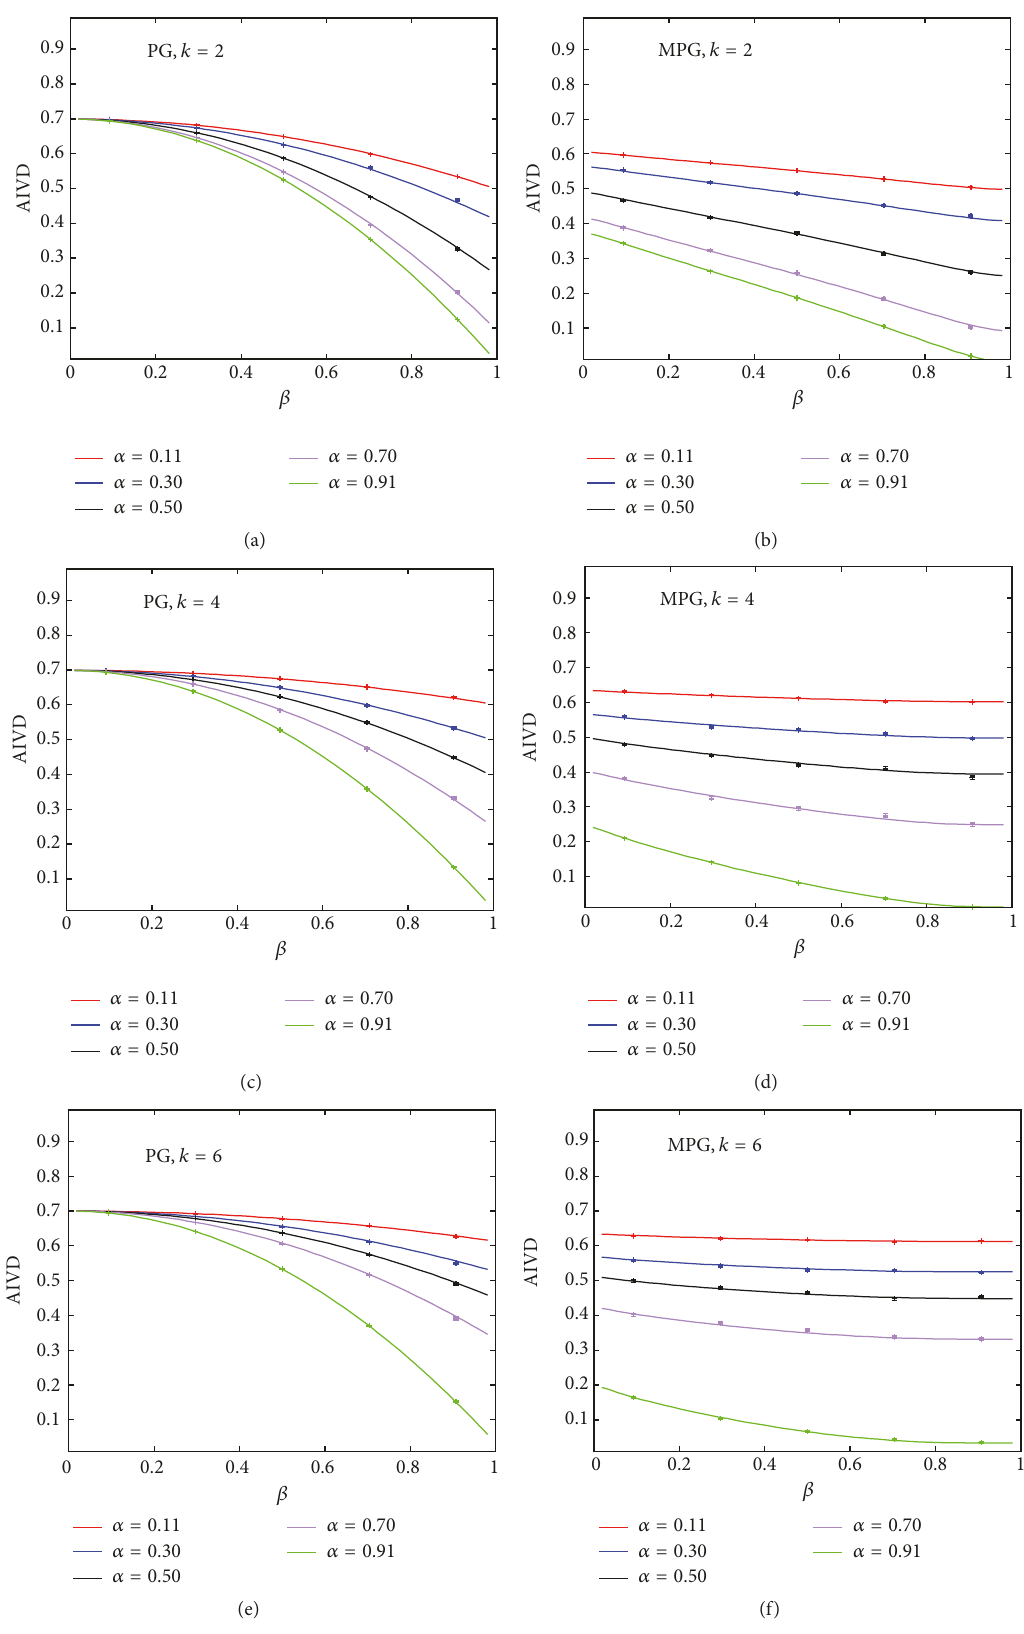
Figure 6: Comparison between numerical (dots) and analytical (line) expected AIVD as a function of 𝛽 , for the PG (a, c, e) and MPG (b, d, f) models, with 𝑘 = 2 (a, b), 𝑘 = 4 (c, d), and 𝑘 = 6 (e, f) prototypes, for several values of 𝛼